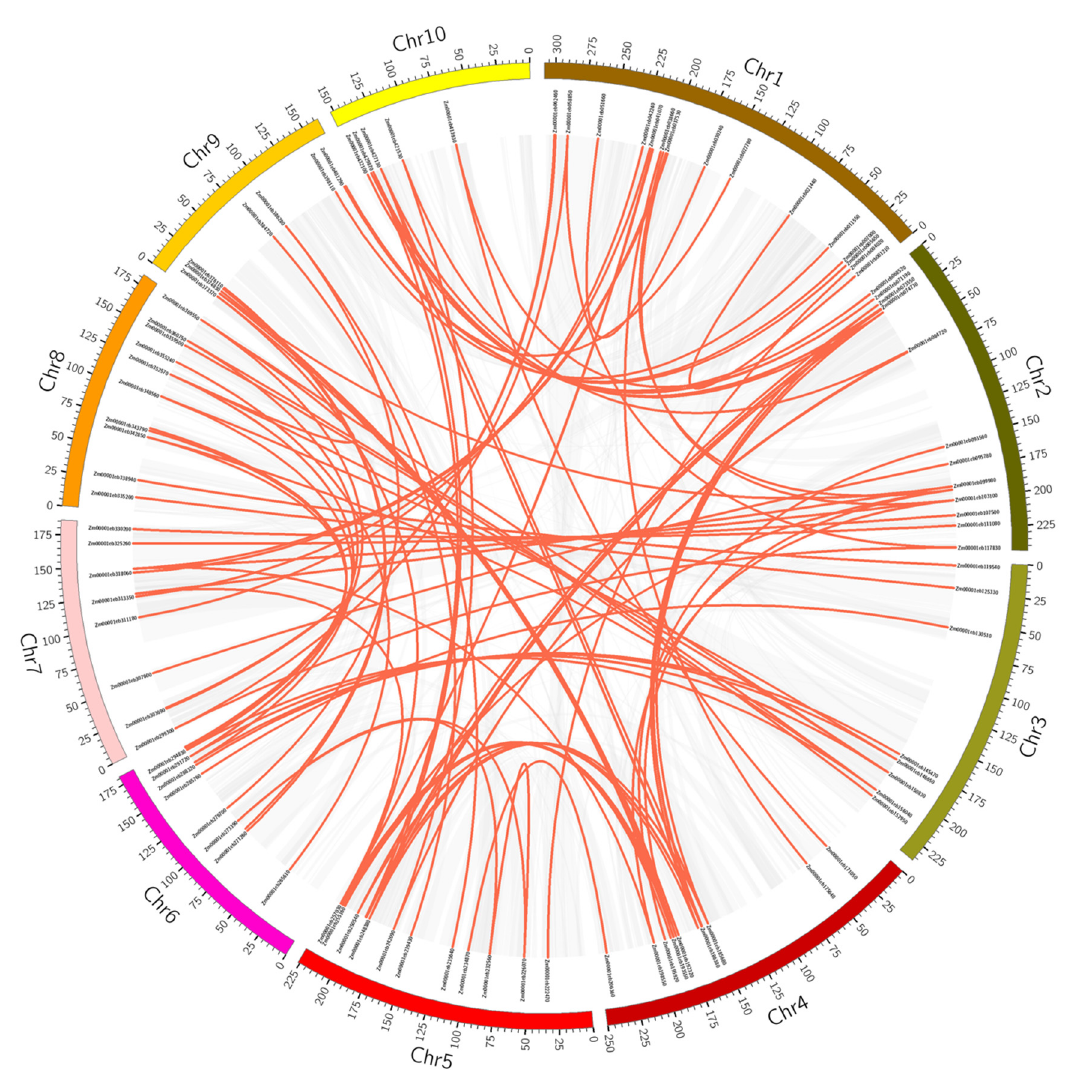
Figure 3. Segmental duplication of ZmAP2/ERFs using circos. The red lines show duplicated ZmAP2/ERFs . Grey lines show the background genome and chromosome number is designated at the nethermost.